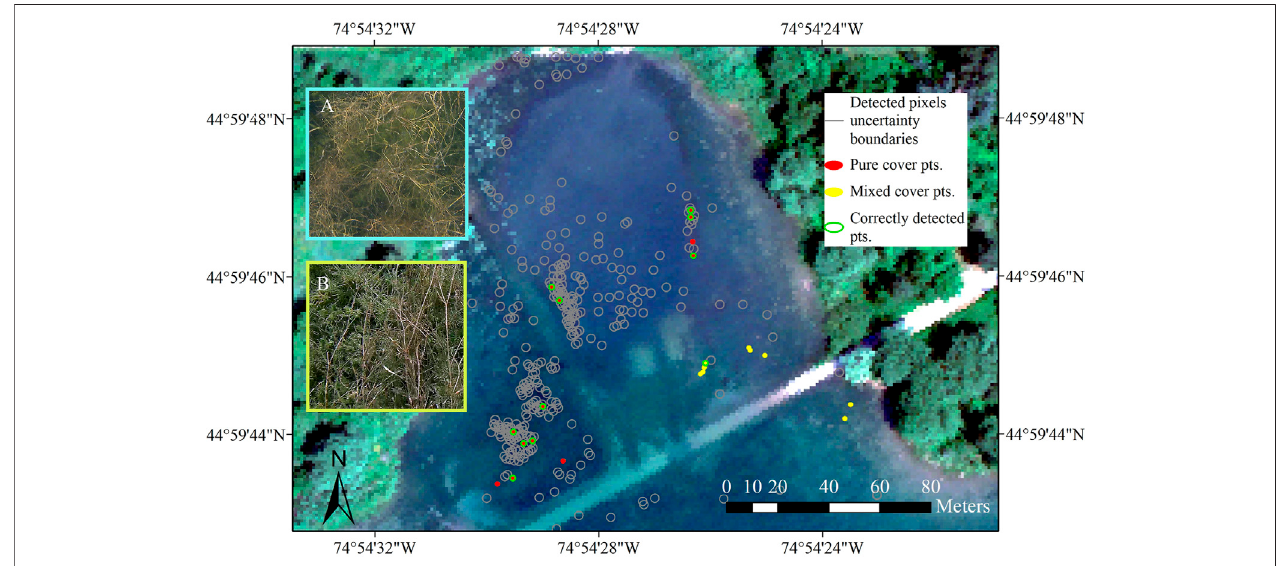
FIGURE 10 | Example of validation for the Potamogeton sp. target detection with grey ellipses around detected pixels, pure validation points, mixed validation points, and validation points correctly detected identi fi ed. Conventionally geocorrected true colour CASI imageshown in background for context. Insets are underwater photograph examples ofpure Potamogeton sp. (A) and mixed (B) Potamogeton sp. and Chara sp. cover. Inthisexample,10ofthe13pure coverpoints were detected shown by the green circles; one mixed cover point was detected.